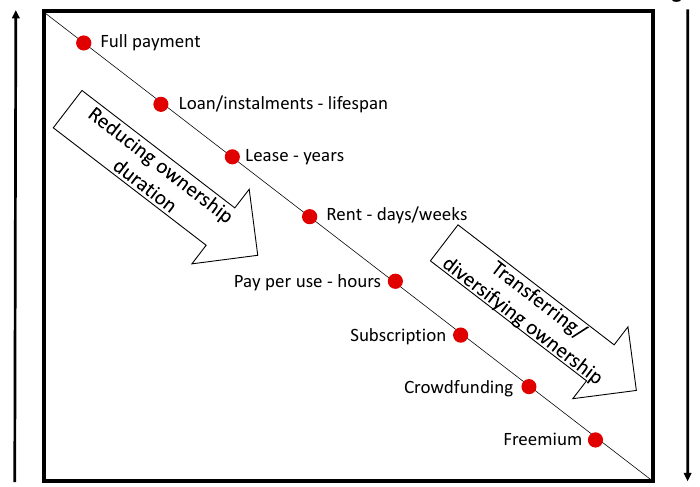
Figure 8. Options for ownership/financing barrier reduction.